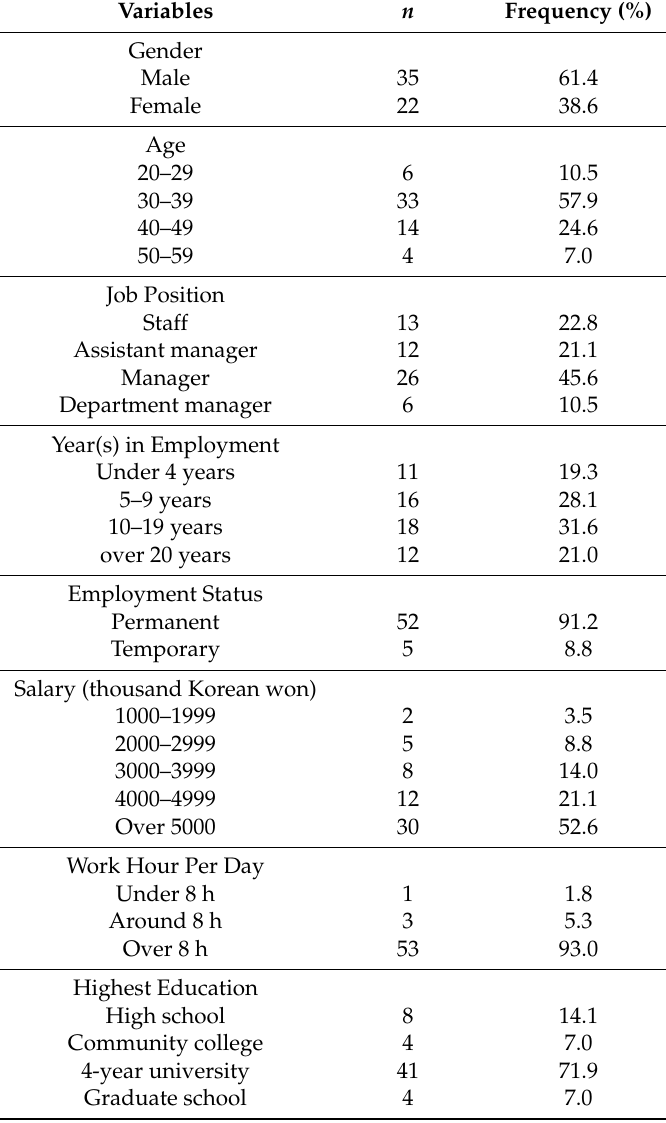
Table 1. Demographic characteristics of participants ( N =